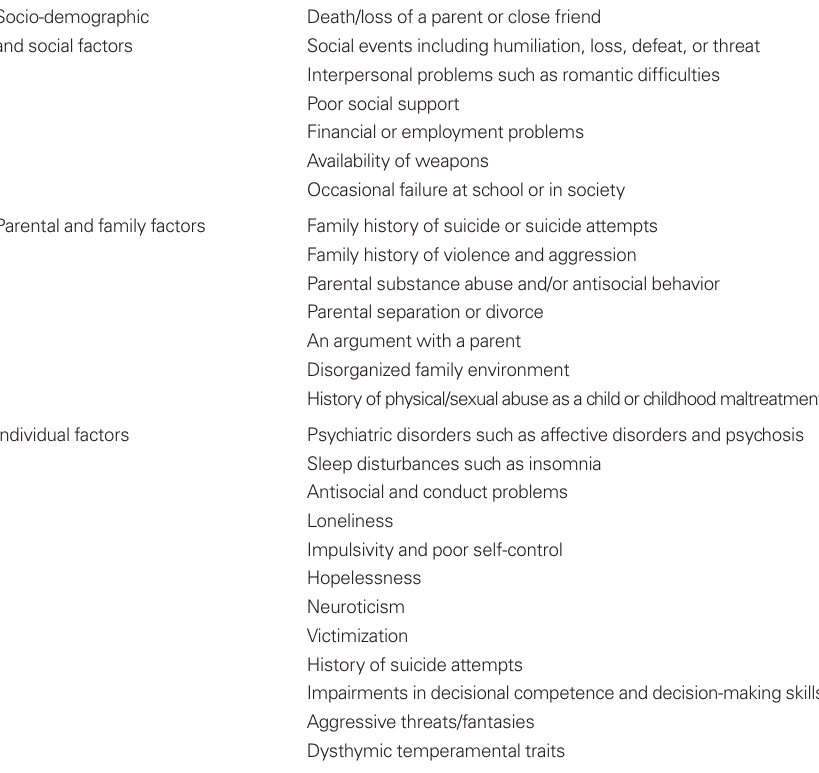
Table 1 | risk factors for suicide risk and early cannabis use in